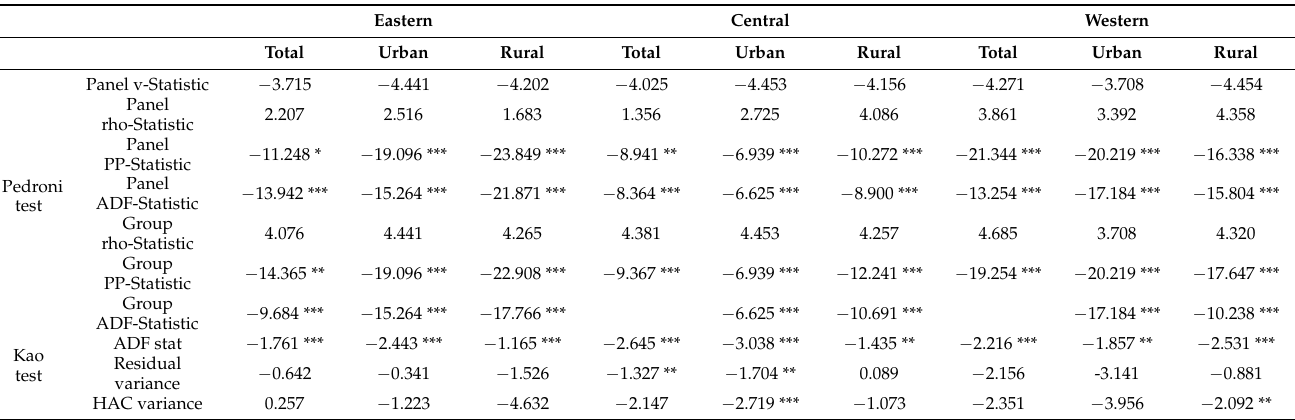
Table 3. Panel cointegration test results. Eastern Central